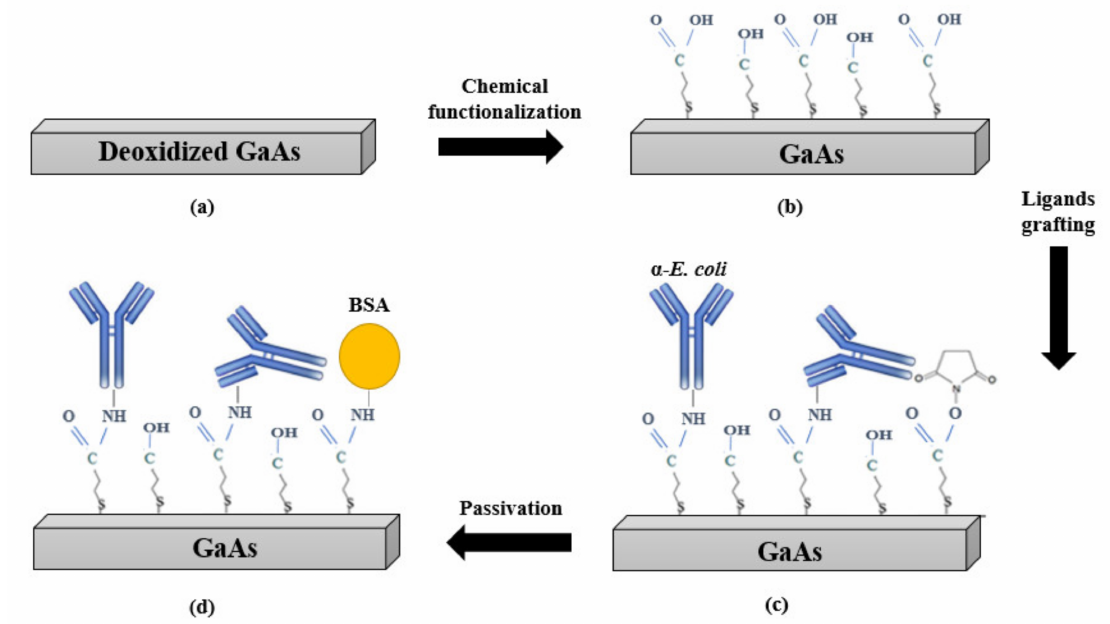
Figure 3. Schematic representation of the bio-functionalization stages: ( a ) bare and deoxidized GaAs surface, ( b ) MHDA/MUDO (1:9) chemical functionalization, ( c ) covalent immobilization of E. coli antibodies, ( d ) surface pas- sivation with BSA and